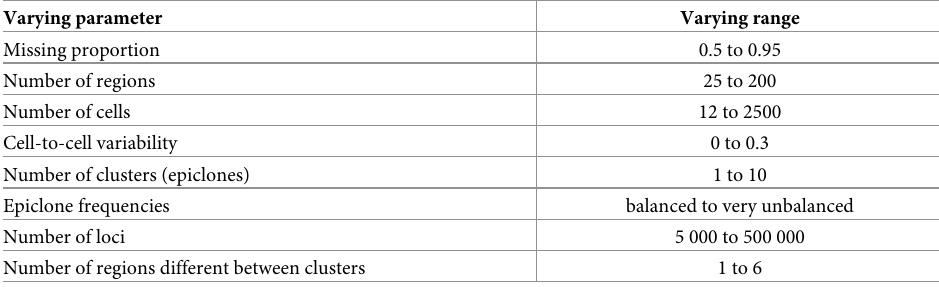
Table 1. Varying parameters and their ranges for synthetic data simulation. For each experiment, we varied one parameter and kept the others fixed. Note that varying the number of regions is equivalent to varying region size because the total number of loci is fixed. Unless otherwise specified, the fixed parameters are: missing proportion 0.8, region size 100, number of cells 100, proportion of cell-to-cell variability 0, number of epiclones 3, equal epiclone fre- quencies (1/3), number of loci 10,000, and number of regions different between clusters 1. For the cell-to-cell variability experiment (Fig 4c), we used 25 regions to have a larger number of loci that differed between clusters. For the number of epiclones experiment (Fig 4d) and the epiclone frequency experiment (Fig 4e), we used 500 cells to allow for enough cells to be represented in each case. For the number of loci experiment (Fig 4f), we also varied the number of regions to keep the differences among clusters fixed (e.g., 50 regions for 5,000 loci, 5,000 regions for 500,000 loci). Varying parameter Varying range Missing proportion 0.5 to 0.95 Number of regions 25 to 200 Number of cells 12 to 2500 Cell-to-cell variability 0 to 0.3 Number of clusters (epiclones) 1 to 10 Epiclone frequencies balanced to very unbalanced Number of loci 5 000 to 500 000 Number of regions different between clusters 1 to